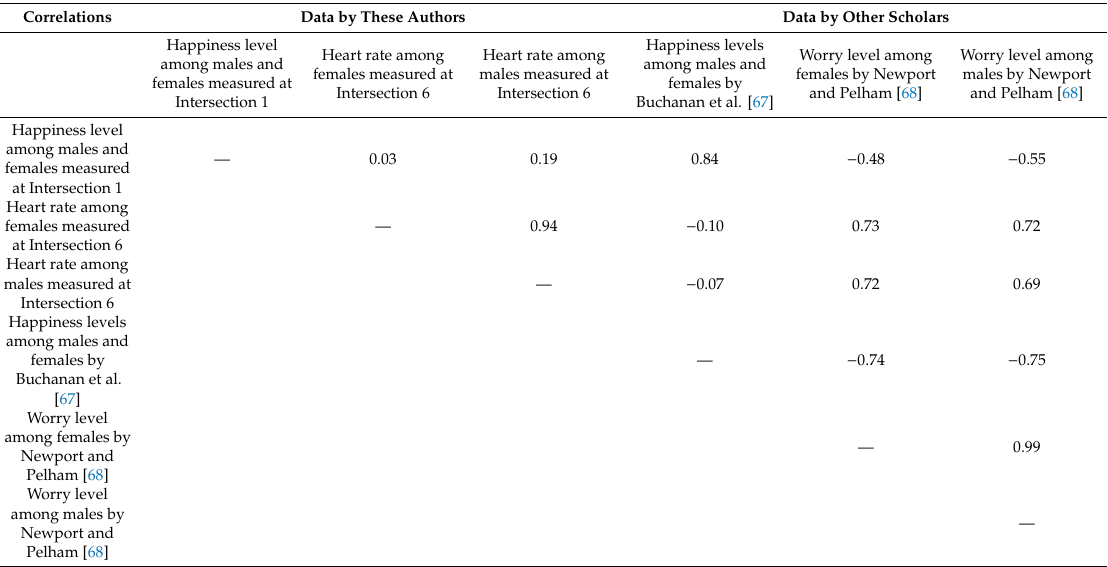
Table 9. Correlations between the data on happiness and heart rate obtained by these authors, and those between happiness and sadness obtained by others, according to various age groups.